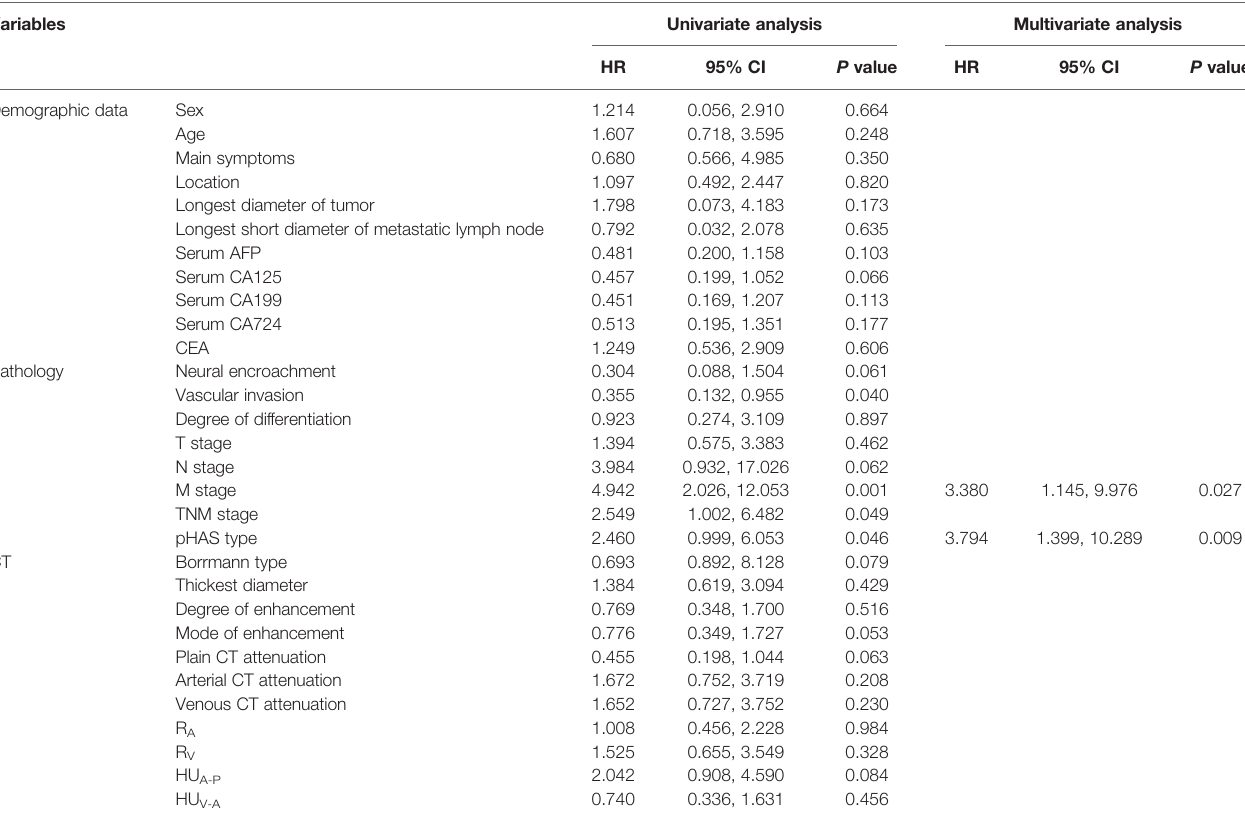
TABLE 4 | Univariate and multivariate analysis using stepwise variable selection of the clinicopathological characteristics and CT features with overall survival.